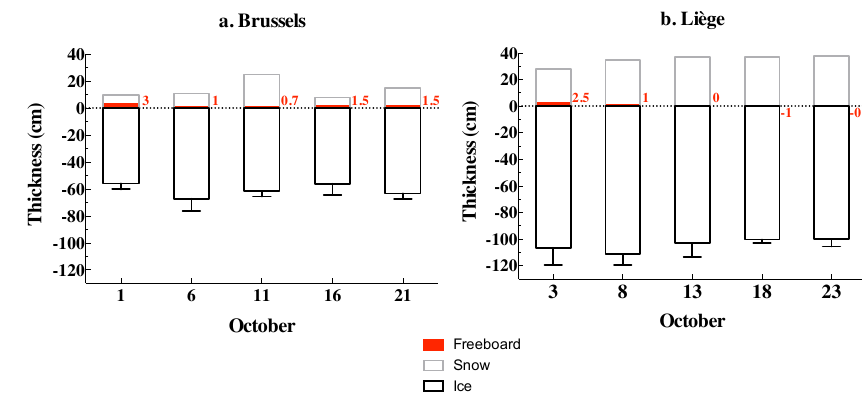
Figure 2. Ice (including range of observed values), snow thickness, and freeboard at the Brussels and Liège sites.